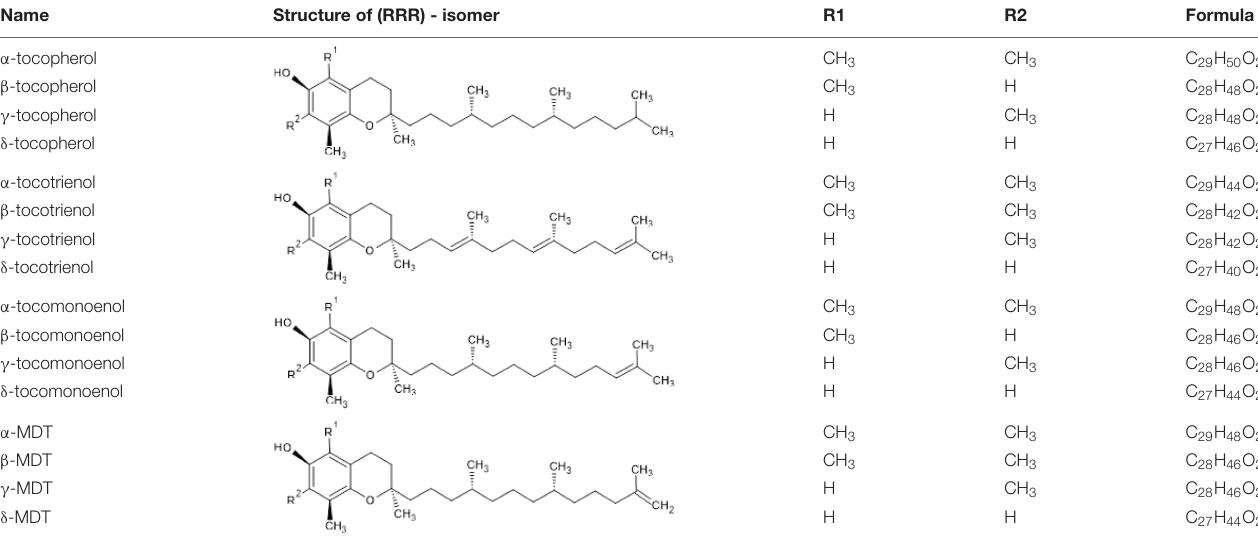
TABLE 1 | Common name, structure, and formula of the four vitamin E families. Name Structure of (RRR) -